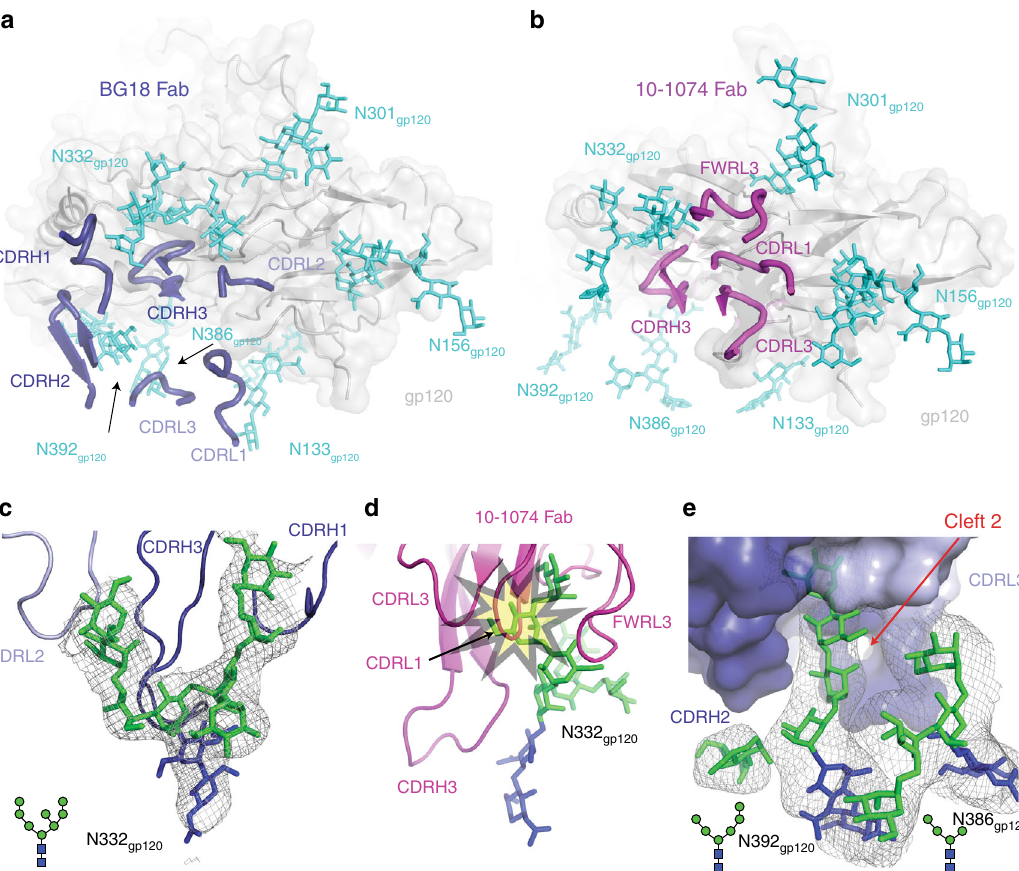
Fig. 4 Glycan interactions with V3/N332 gp120 bNAbs in structures including natively glycosylated Env. a , b Comparison of the orientations on gp120 (gray surface and cartoon) of the CDR loops from ( a ) BG18 (blue, ribbon) and ( b ) 10-1074 (magenta, ribbon) demonstrating that the BG18 variable domains are rotated clockwise about CDRH3 relative to the 10-1074 variable domains. The distinct BG18 orientation on gp120 resulted in contacts with N156 gp120 , N386 gp120 , and N392 gp120 glycans (cyan, sticks) in proximity to the V3-base. Red dotted outline: Differences in the N332 gp120 glycan conformation on BG505 Env bound to BG18 ( a ) or to 10-1074 ( b ). c Close-up of BG18 interaction with the N332 gp120 glycan showing CDRH3, CDRH1 and CDRL2 loops at the glycan interface. d Overlay of BG18-BG505 and 10-1074 – BG505 (PDB 5T3Z (http://dx.doi.org10.2210/pdb5T3Z/pdb)) structures showed that the BG18-bound N332 gp120 glycan conformation would clash (yellow star) with light chain CDR loops of 10-1074 and other PGT121-like bNAbs that display nearly identical binding modes. e Surface representation of BG18 interactions with the N392 gp120 and N386 gp120 glycans showing the N392 gp120 glycan buried (~800 Å 2 total BSA) inside cleft 2 located between the CDRH3 and CDRL1/3 loops. The N386 gp120 glycan associates weakly with light chain BG18 (45 Å 2 total BSA), but forms branch – branch interactions with the N392 gp120 glycan. c , e Electron density contoured at 1 σ from 2 F obs − F calc composite annealed omit maps calculated with phases from models with glycan coordinates omitted to reduce potential phase bias (gray